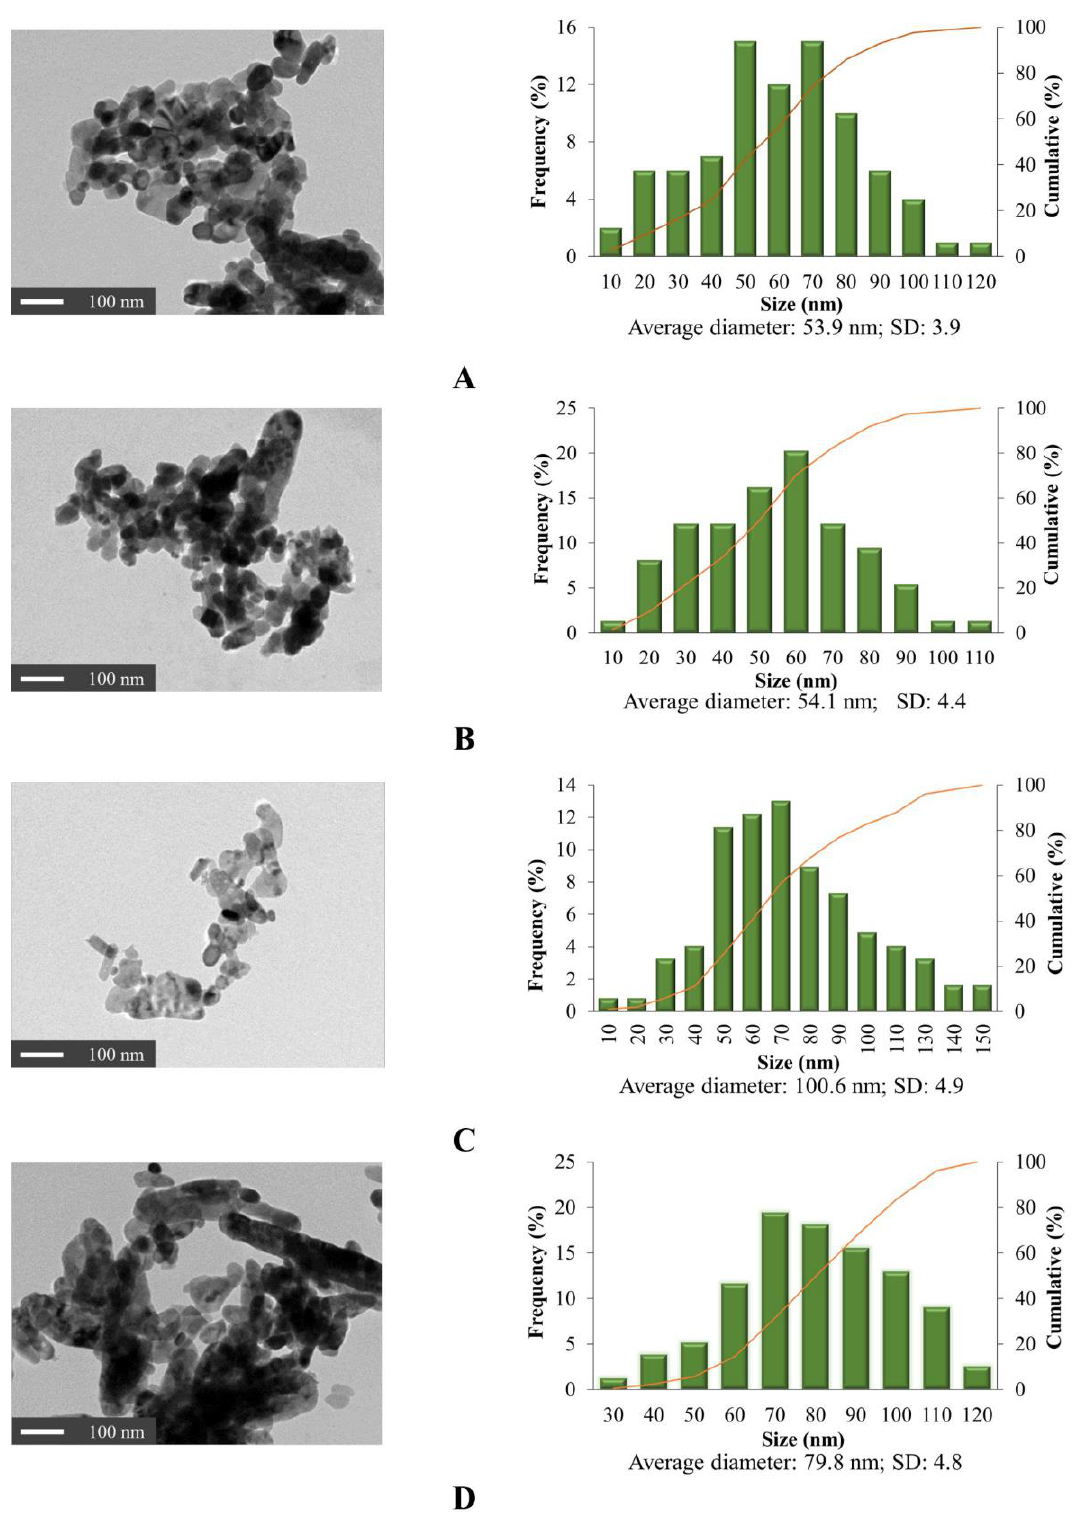
Figure 2. Transmission electron microscope (TEM) micrographs and grain size analysis of ( A ) commercial α -Fe 2 O 3 , ( B ) synthesized α -Fe 2 O 3 at 2 × critical micelle concentration (CMC) SDS, ( C ) synthesized α -Fe 2 O 3 at 2 × CMC CTAB and ( D ) synthesized α -Fe 2 O 3 at 2 × CMC TX100.